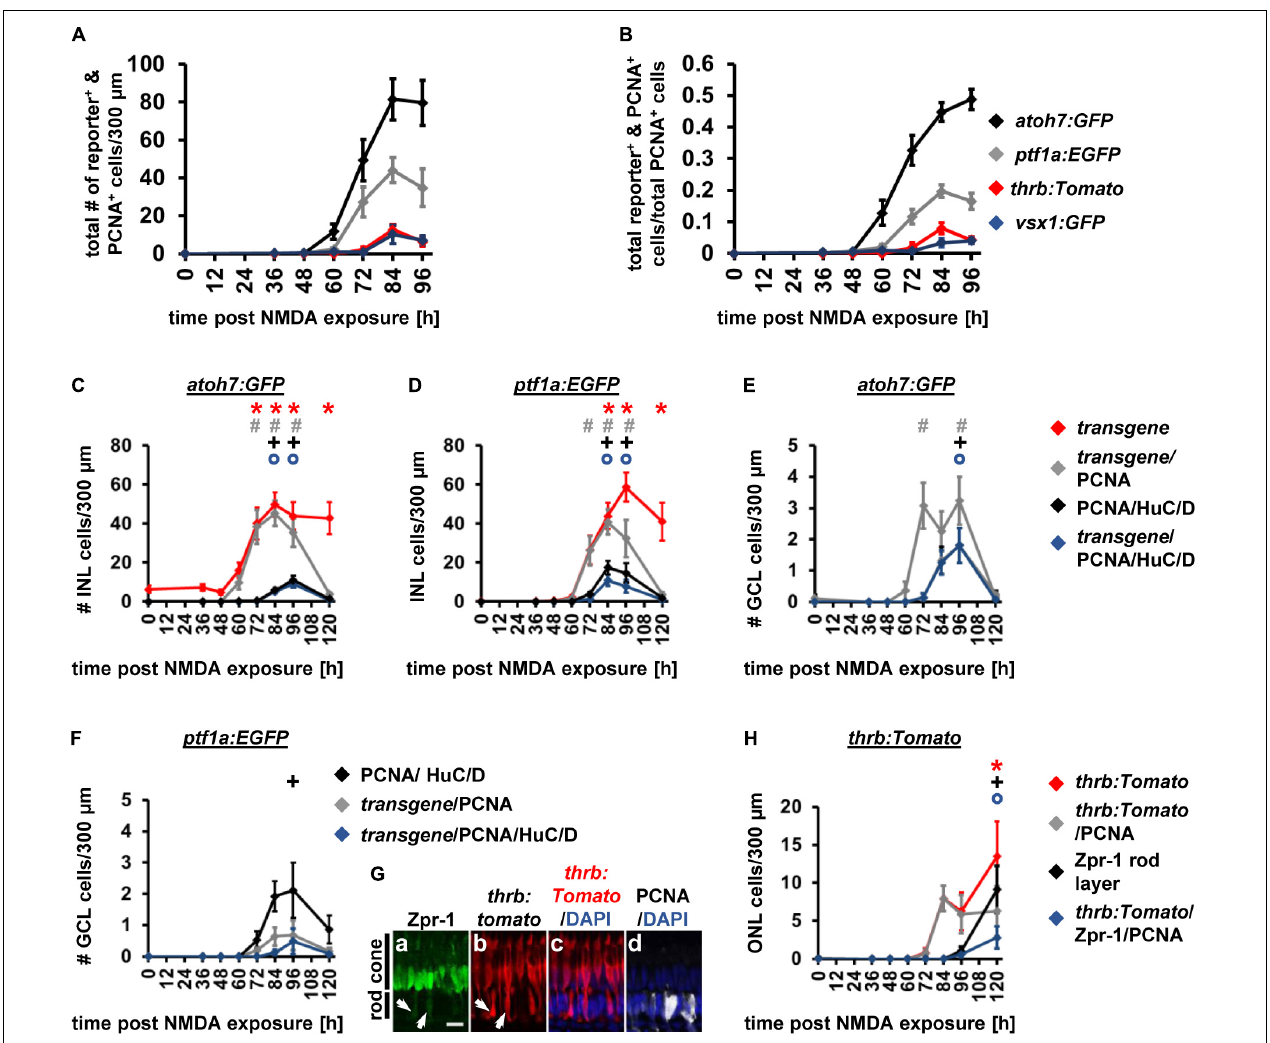
FIGURE 9 | Comparison of the temporal expression patterns of neuronal competence factors in the NMDA-damaged retina. (A,B) Total number (ONL, INL, and GCL combined) of atoh7:GFP- , ptf1a: EGFP-, thrb:Tomato- and vsx1:GFP- positive cells (i.e., reporter-positive cells) that express PCNA (A) and when normalized to the total number of PCNA-positive cells in NMDA-damaged retinas (B) . Mean ± SE, n ≥ 7. (C,D) Number of transgene-positive cells, transgene-positive cells that express PCNA and those that are triple-positive for the transgene, PCNA and HuC/D as well as the number of HuC/D and PCNA-positive cells in the INL of NMDA-exposed Tg[atoh7:GFP]rw021 (C) and Tg[ptf1a:EGFP]jh1 zebrafish retinas [ (D) ; 0, 36, 48, 60, 72, 84, 96, and 120 h post NMDA exposure]. (E,F) Number of transgene-positive cells that express PCNA and those that also co-localize with HuC/D as well as the number of HuC/D and PCNA-positive cells in the GCL of NMDA-exposed Tg[atoh7:GFP]rw021 (E) and Tg[ptf1a:EGFP]jh1 zebrafish retinas (F) . Mean ± SE, n ≥ 9. (G) Single confocal z-stack images of Tg[thrb:tomato]q22 retinas (Gb,c) at 120 h post NMDA exposure labeled for Zpr-1 (Ga) , PCNA (Gd) , and DAPI (Gc,d) . Arrows, Zpr-1 and thrb:tomato -double positive cells in the rod photoreceptor cell nuclear layer. Scale bar, 10 µ m (Ga) . (H) Number of Zpr-1-positive cells , thrb:Tomato -positive cells, those that co-labeled with PCNA or those triple-positive for thrb:Tomato , PCNA and Zpr-1 in the rod ONL of NMDA-exposed retinas. Mean ± SE, n ≥ 8, * p Tukey < 0.05, # p < 0.05, + p < 0.05, and ◦ p < 0.05 indicate comparisons to 0 h post NMDA for the different measures that were assessed. The symbols are color-coded accordingto the line that they represent in the corresponding graphs ( p ANOVA , see Table 1